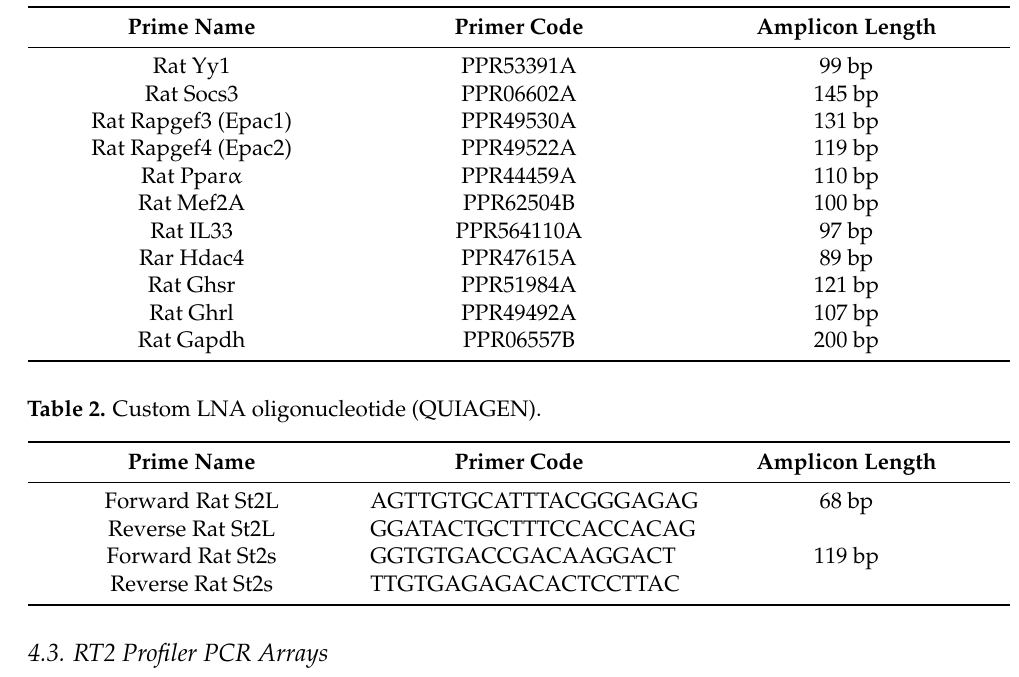
Table 1. RT2qPCR Primer Assay QIAGEN.